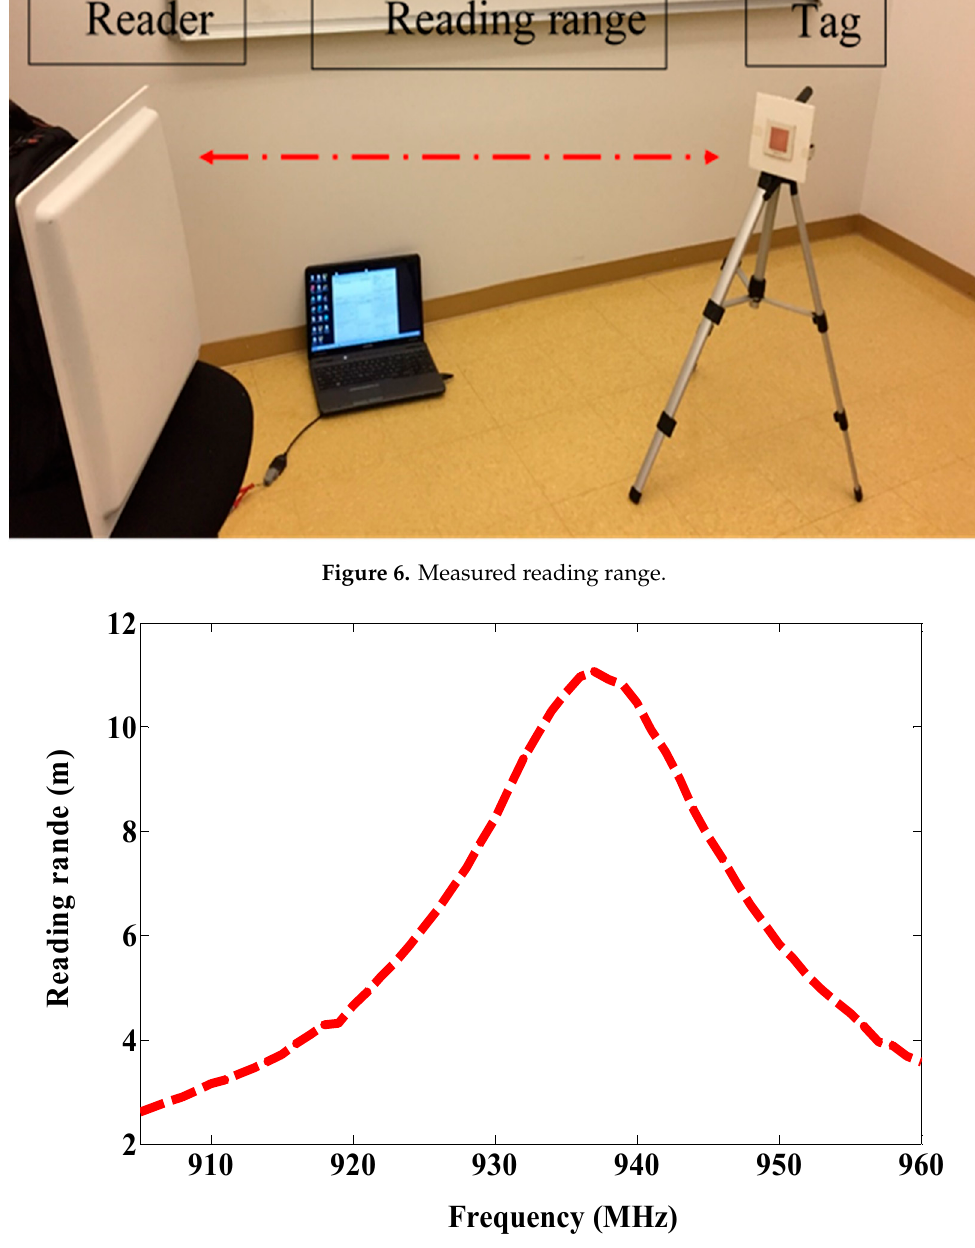
Figure 7. Measured reading range of antenna A.